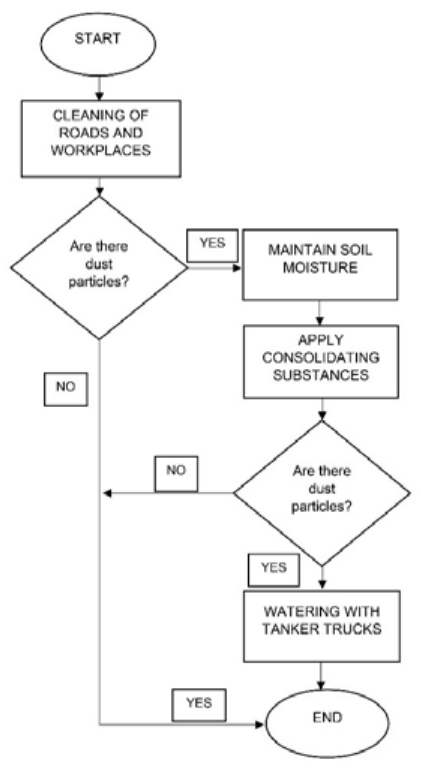
Fig. 2: Flowchart to reduce dust on roads and workplaces